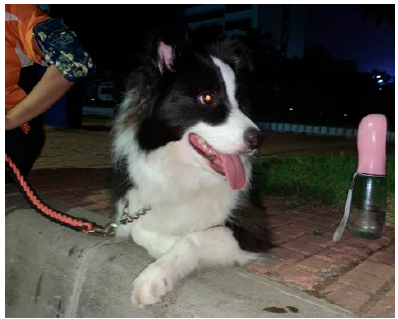
Figure 3. Niuniu still walking at midnight.